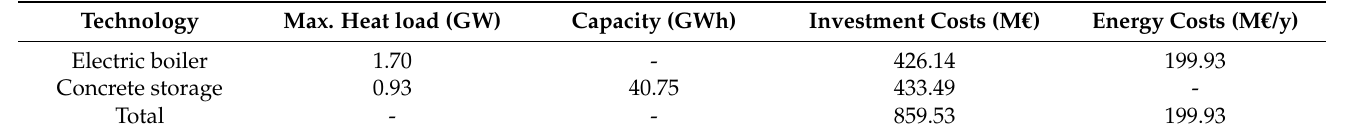
Table 4. Optimal system configuration and resulting costs for Case 1.